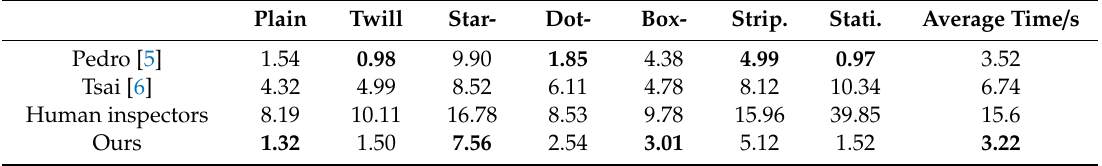
Table 2. Comparison of average computational time by four di ff erent